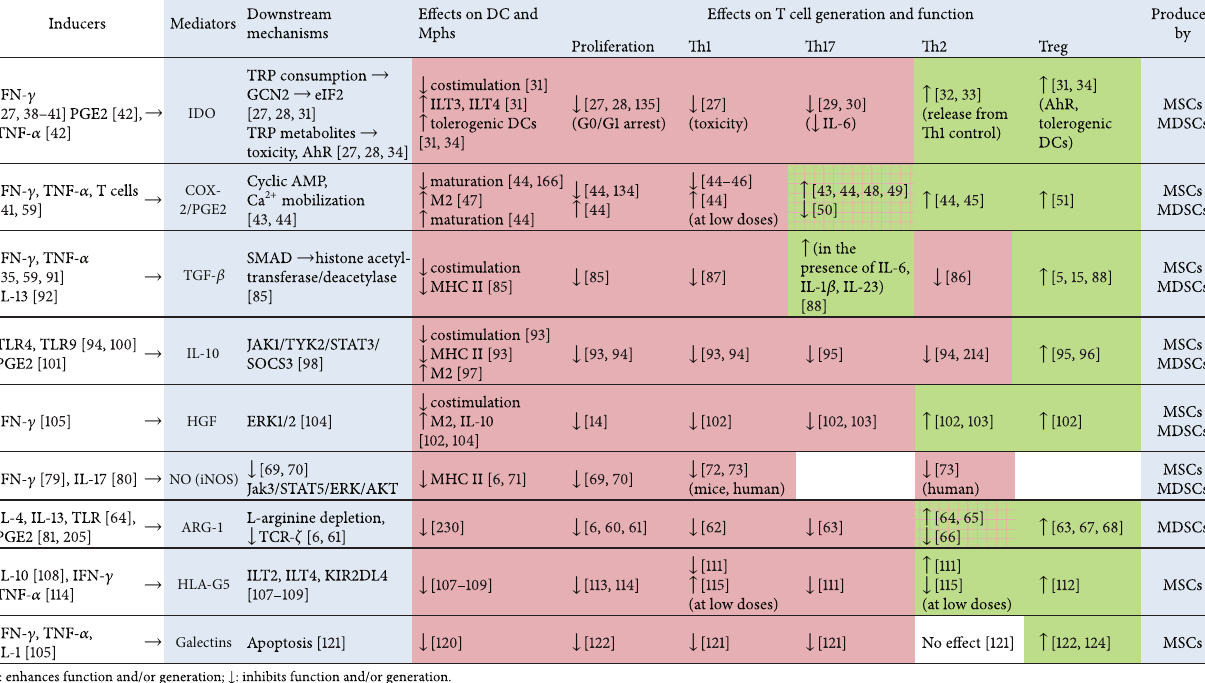
Figure 1: Main mediators utilized by MSCs and MDSCs to suppress T cell responses and their